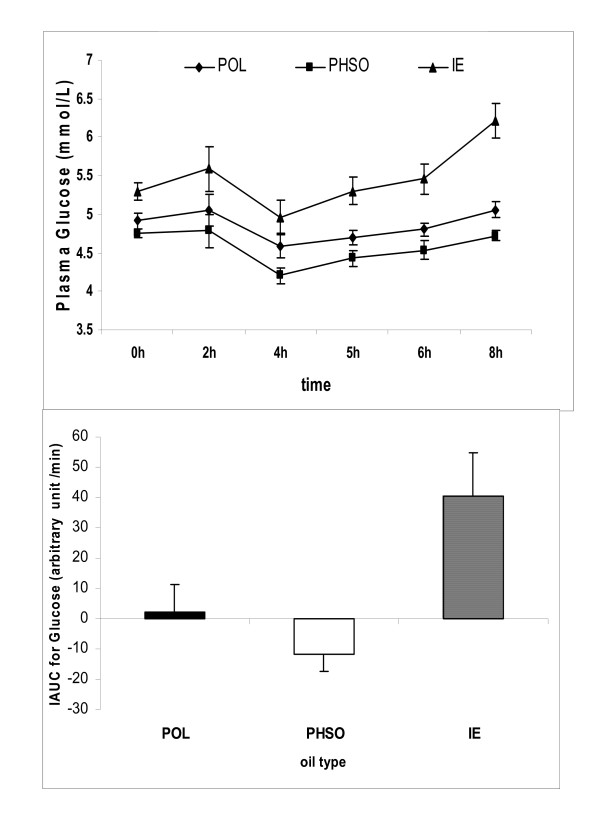
a (top) The relative profiles for postprandial glucose are depicted for 8 h following a challenge breakfast with either POL, PHSO, or IE fat in the test meal (means ± SE, n = 19). After 6 h and 8 h the IE glucose was significantly greater than PHSO and POL. For the entire period the IAUC for IE was 40–45% greater than the other two fats (Figure 2b, below) Postprandial meals were consumed at the beginning of wk3 during each diet period (means ± SE, n = 19).